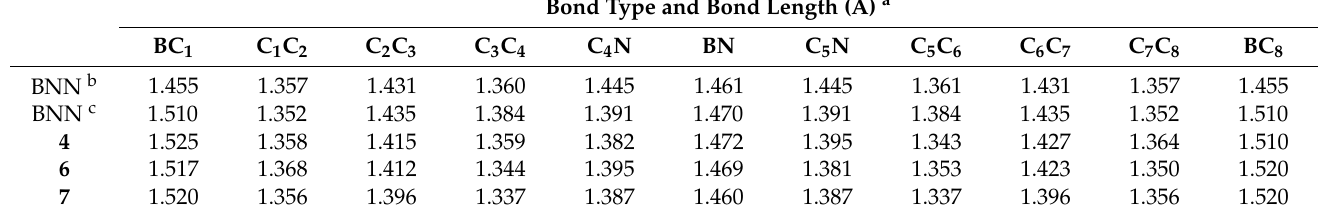
Figure 2. Aromaticity of nitro-BNNs calculated using HOMA model.